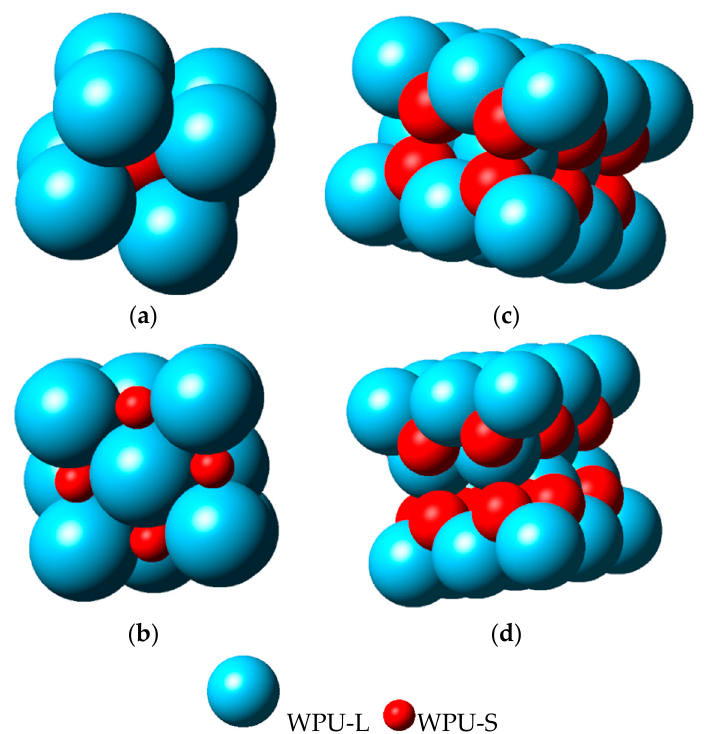
Figure 6. Three-dimensional stacked models: ( a ) simple cubic accumulation; ( b ) face-centered cubic accumulation; ( c ) cubic close packing; and ( d ) hexagonal closest packing.